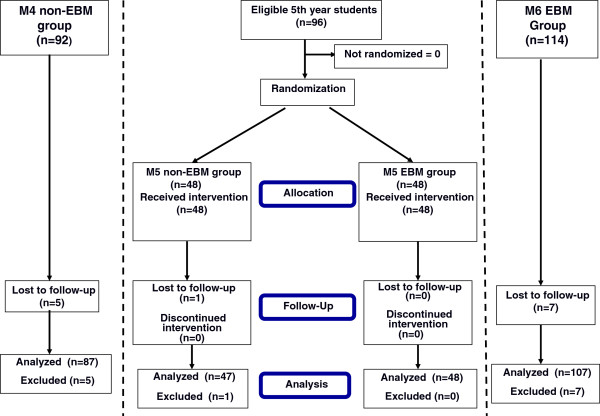
Flow diagram of study participants. Flow diagram summarizing the groups of medical students and the progress of their participation in the study. M4 non-EBM=4th year students with no evidence-based medicine training; M5 EBM and M5 non-EBM=5th year medical students with and without the evidence-based medicine course; M6 EBM=6th year students exposed to the evidence-based medicine course during the year prior to assessment.